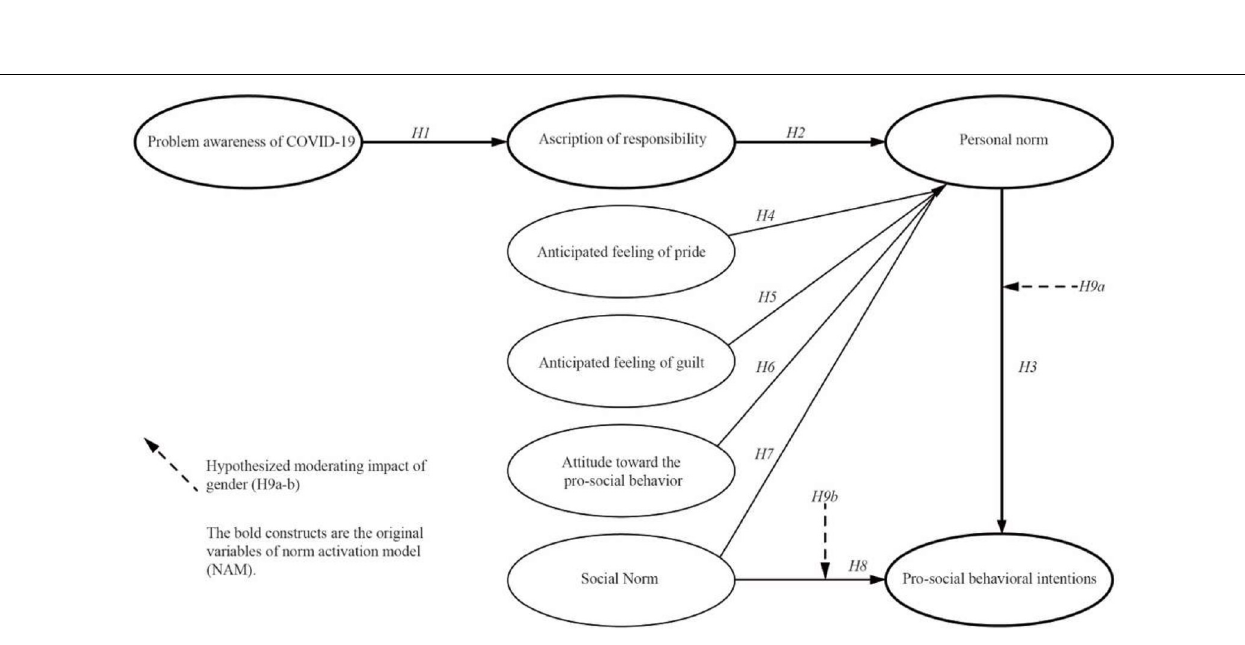
FIGURE 3 | Proposed conceptual